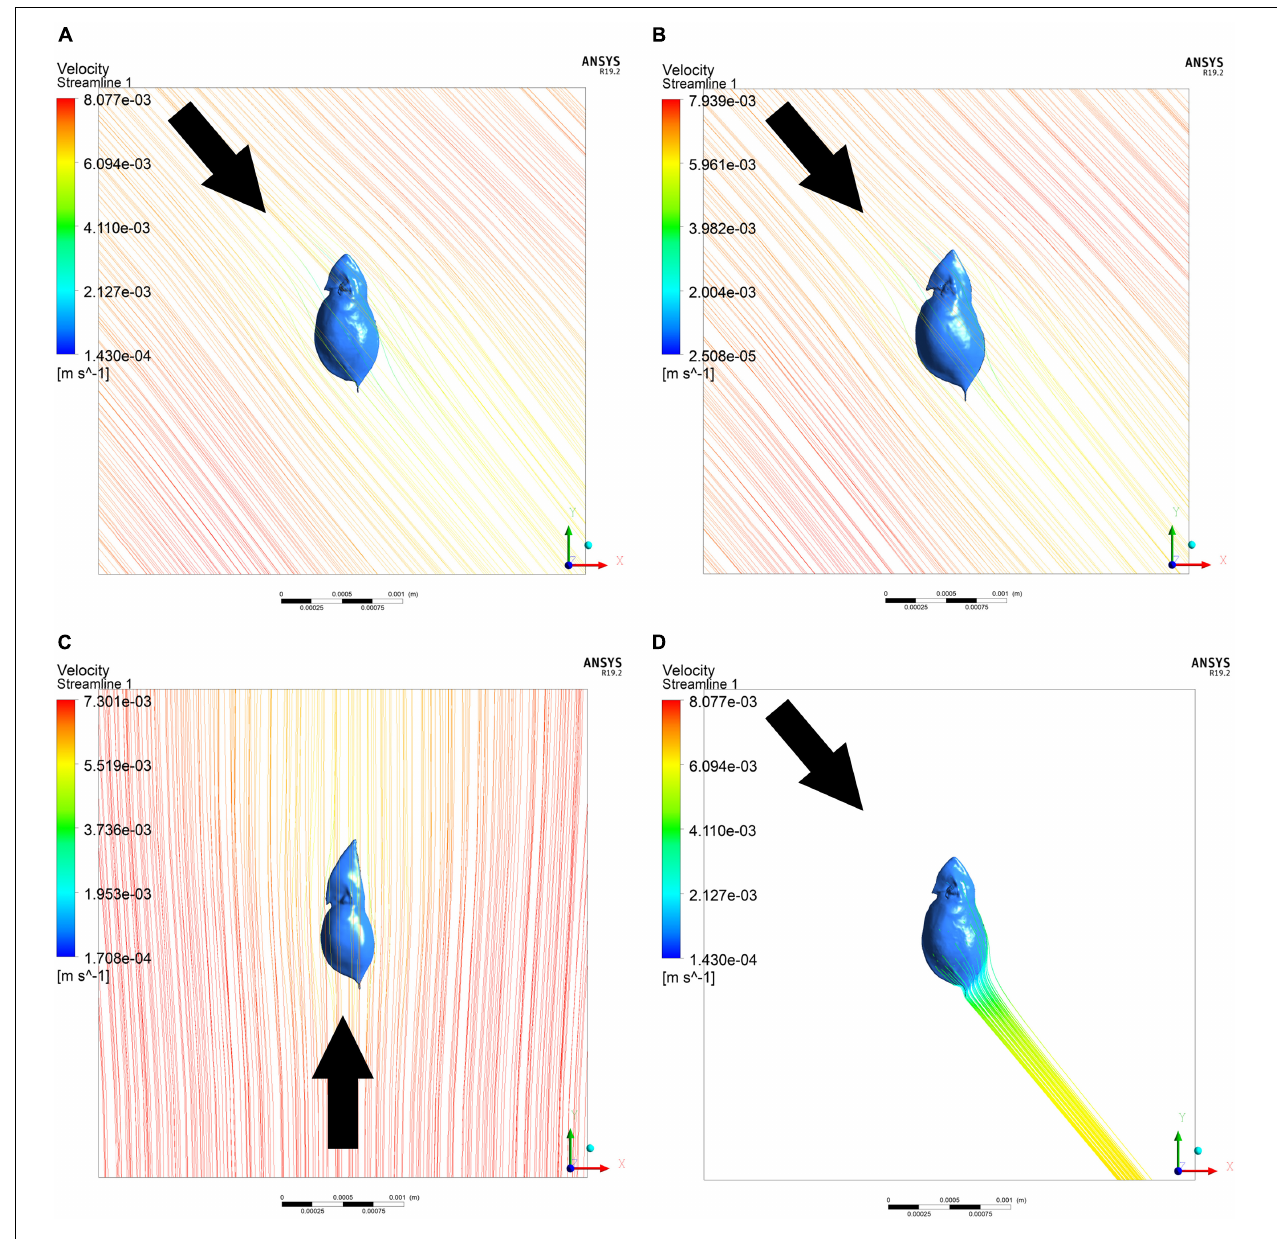
FIGURE 4 | Exemplary 3D-simulations of streamlines around D. cucullata . Drag forces were simulated in typical (A) , Chaoborus -exposed (B) , and turbulence-exposed D. cucullata (C) . Streamline analysis allows the simulation of different angles of attack, e.g., of 40 ◦ (A,B,D) as well as from directly beneath (180 ◦ , C ). Investigating the trails of the model allows to compare differences between models (D) . Arrow gives the direction of water